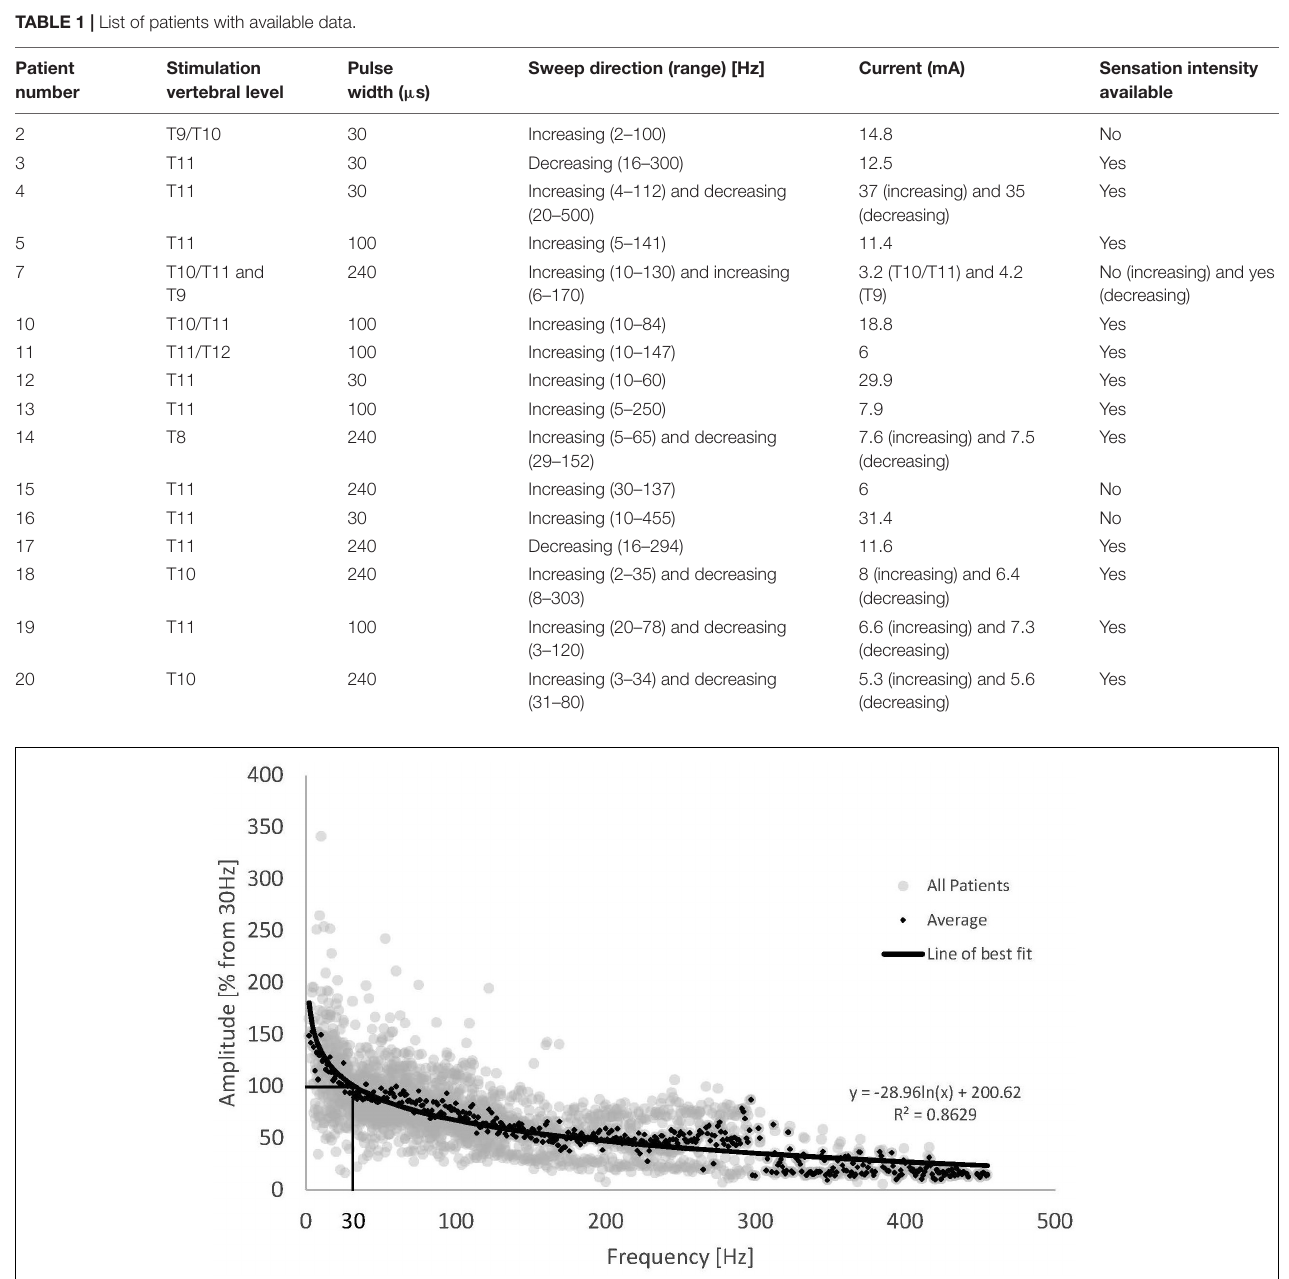
FIGURE 3 | Normalised ECAP amplitude against stimulus frequency for all available data (grey dots) and the resulting average (black diamonds). Data from 16 patients and 22 frequency sweeps. A logarithmic fit was added to the average ECAP amplitudes.